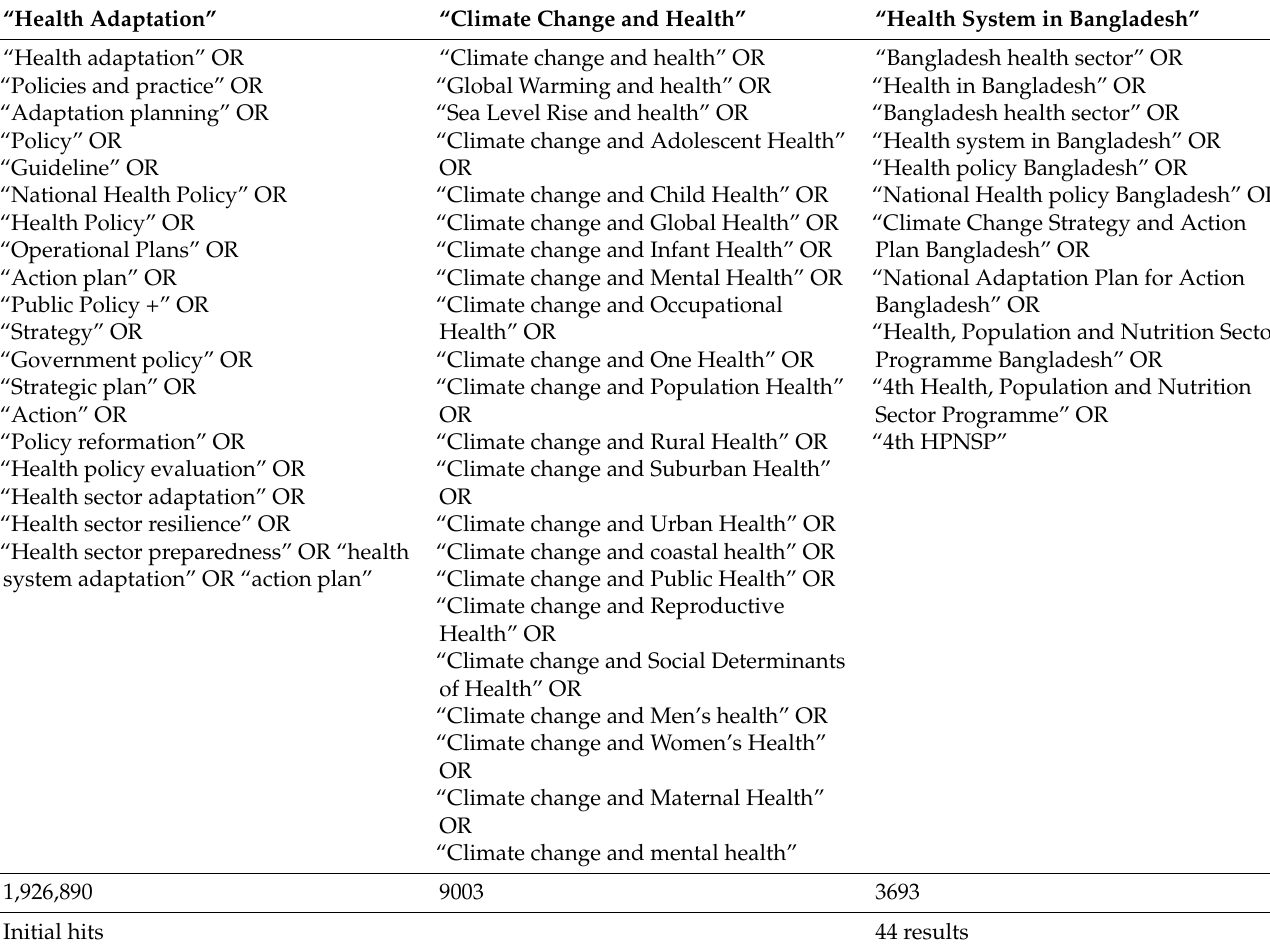
Table A1. Key words and ‘Mesh’ terms for database